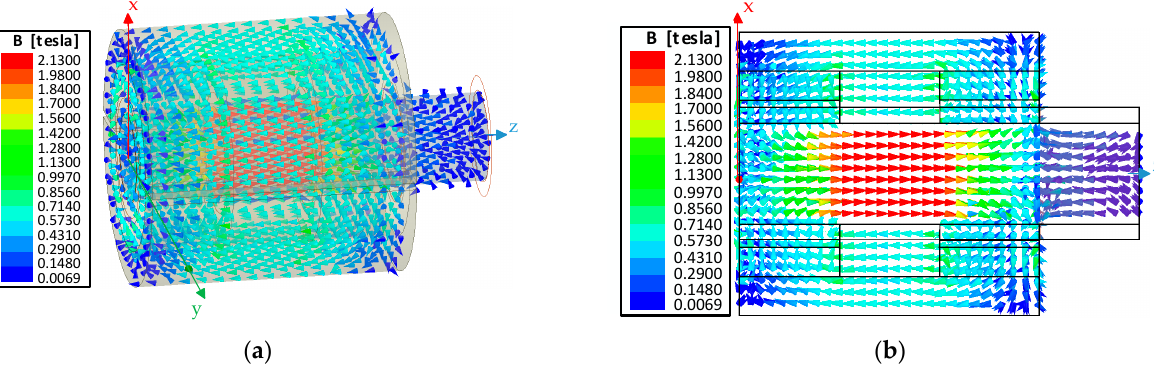
Figure 10. Magnetic flux vector density of the CDCLM. ( a ) Full view; ( b ) Cross-sectional view. The magnetic field created by the permanent magnets completes its path in the − z direction through the left-right yokes and in the +z direction through the core, since the direction of magnetic flux in a permanent magnet is from the N pole to the S pole.